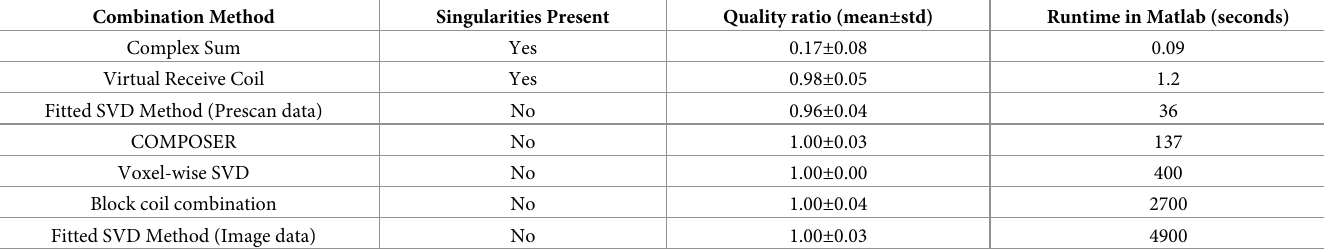
Table 1. Summary of coil combination methods quality and single threaded runtime when implemented in Matlab R2018a. Combination Method